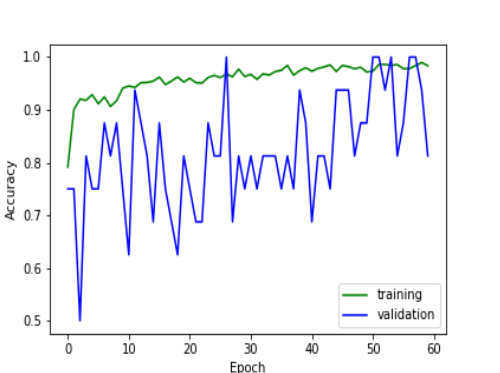
Figure 6(b): Validation loss (in blue) and Training Loss (in green) during the training of model for the categorization of radiograph